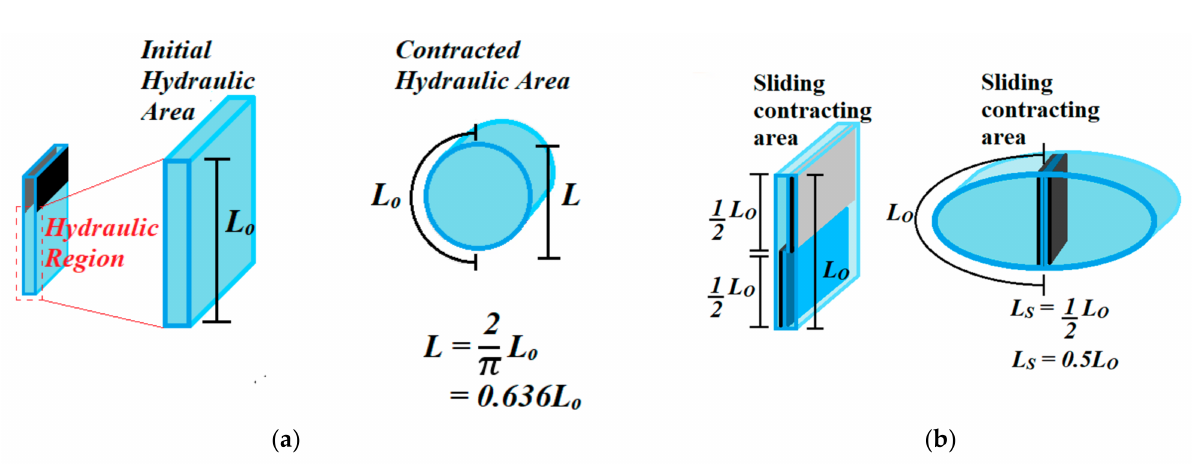
Figure 11. ( a ) The maximum theoretical secondary hydraulic transmission of the zip mechanism as depicted by the peano actuator design and ( b ) the maximum theoretical secondary hydraulic transmission of the sliding